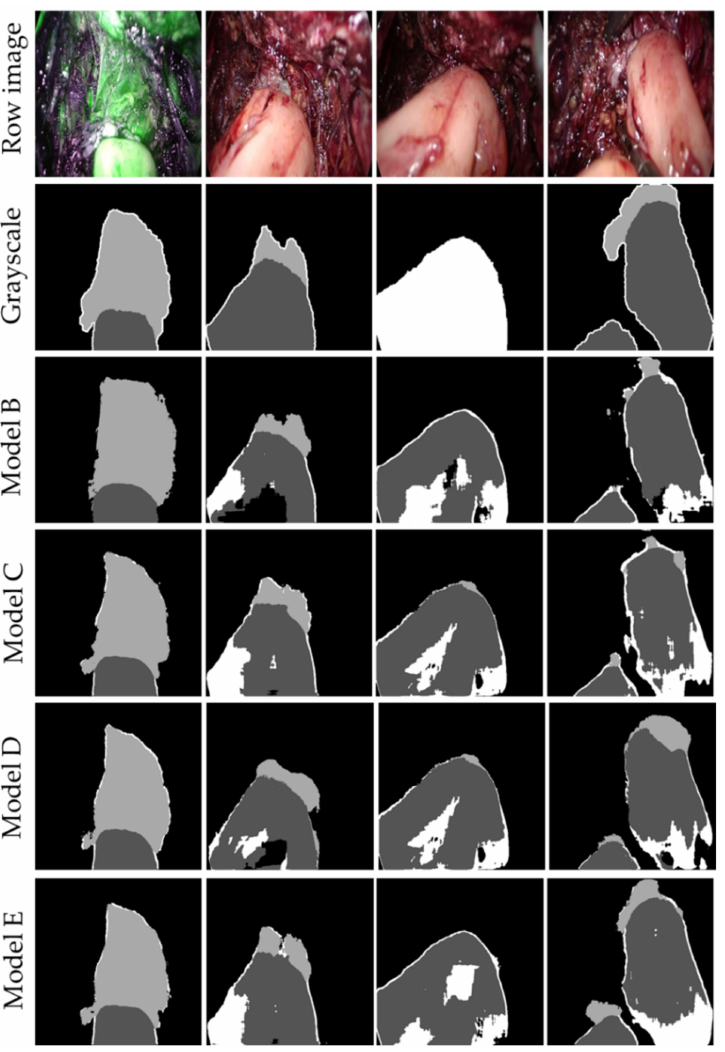
Figure 5. Automatic segmentations produced by models B, C, D, and E. In the top row, RGB images from the test set scaled to 512 × 512 pixels. In the next row, the ground truths show each of the 4 classes with different grey intensities. In the following rows, the masks segmented by models B, C, D, and E,